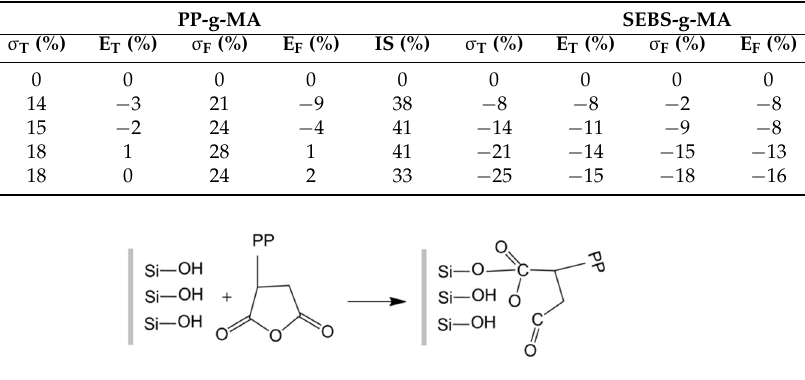
Figure 4. Chemical reaction between PP-g-MA and SGF. Figure 5. Chemical reaction between SEBS-g-MA and SGF.